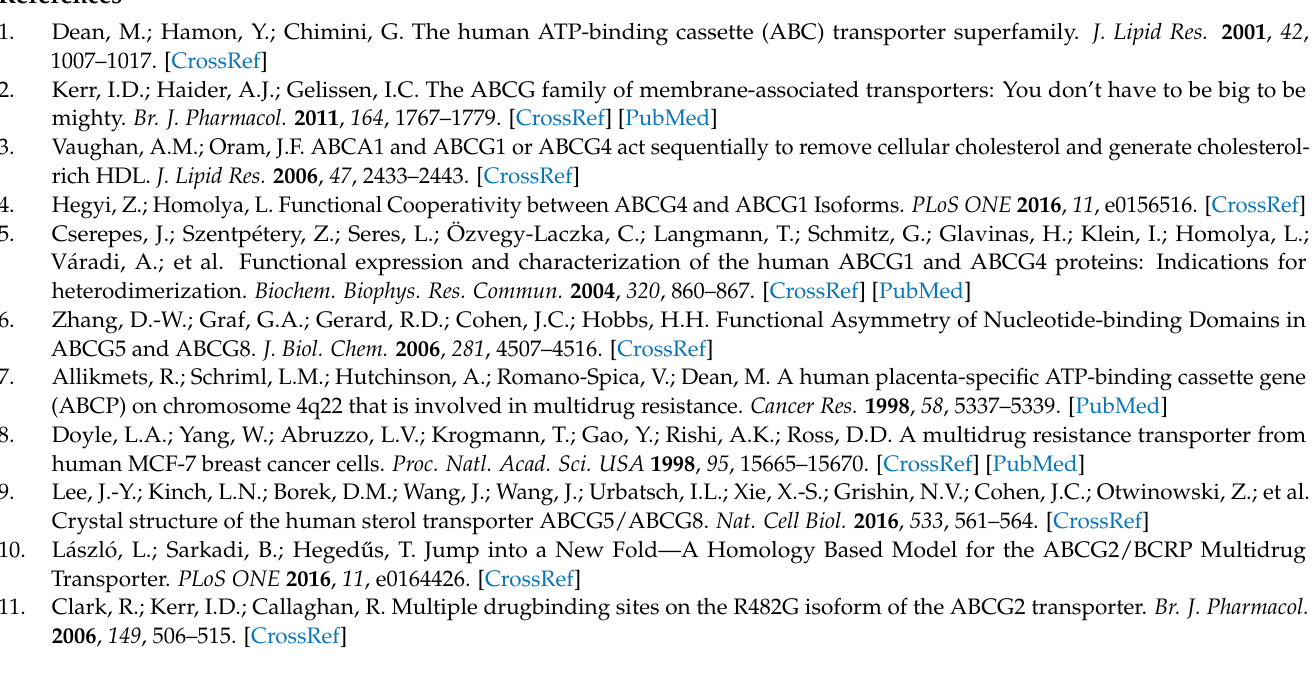
The conservation pattern (ABCG1, ABCG4), (ABCG2), (ABCG5), (ABCG8) on ABCG5/G8; Supple- mentary Figure S3: Serines and threonines in the corkscrew; Supplementary Figure S4: Binding pockets of ABCG2, ABCG5, and ABCG8; Supplementary Figure S5: Well-populated type II diver- gence patterns; Supplementary Table S1: Protein Sequences used to identify functionally divergent positions; Supplementary Table S2: Number of columns with a given conservation pattern across the whole alignment; Supplementary Table S3: Partial contingency table for conservation patterns in the polar relay; Supplementary Table S4: Frequency of conservation patterns in the triple helical bundle; Supplementary Table S5: Frequency of conservation patterns at dimer interfaces; Sup- plementary Table S6: Residues contributing to the binding pockets of ABCG2 and ABCG5/G8; and Supplementary Table S7: Mutations to positions with conservation patterns of interest,